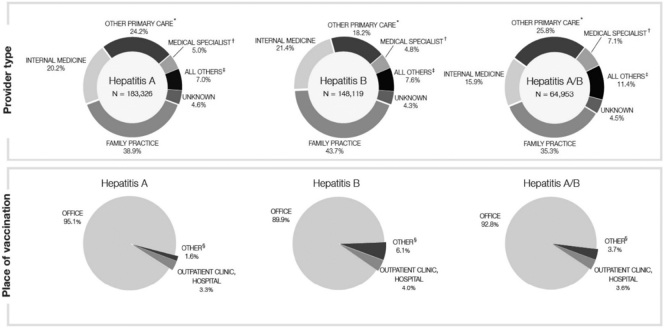
Provider type and place of vaccination, in the overall eligible population, by type of hepatitis vaccine (hepatitis A, hepatitis B, and hepatitis A/B), 2007–201511Patients who initiated two monovalent vaccine series were included in both cohorts, hepatitis A and hepatitis B.⁎‘Other primary care’ includes general pediatrics, obstetrics & gynecology, and other primary care physicians; †‘Medical specialist’ includes infectious diseases, gastroenterology, pediatrics, endocrinology, nephrology, and all other specialists; ‡‘All others’ includes surgery and surgical specialties, nurse practitioners, nurses, public health agency, pharmacists, and all other health care providers; §‘Other’ includes hospital, pharmacy, end stage renal disease facility, and all others. NOTE: Percentages might not add up to 100% due to rounding.